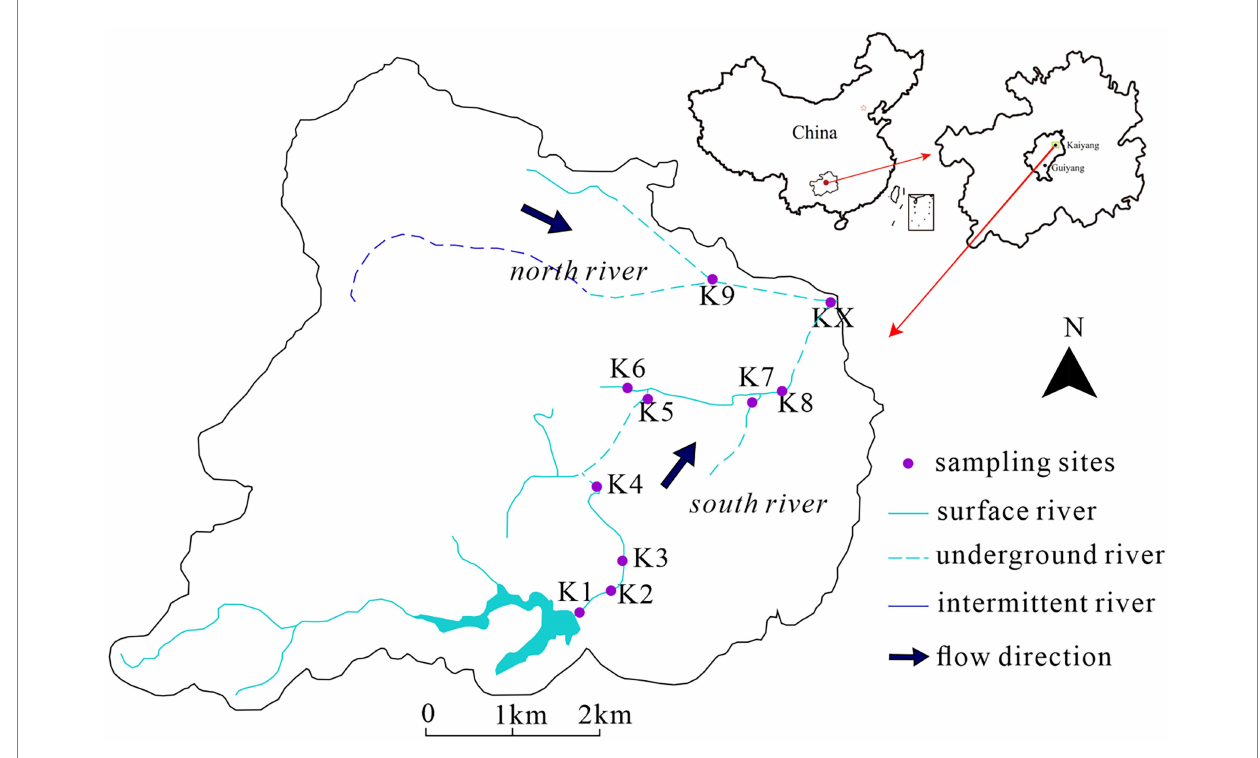
FIGURE 1 The sampling sites in study